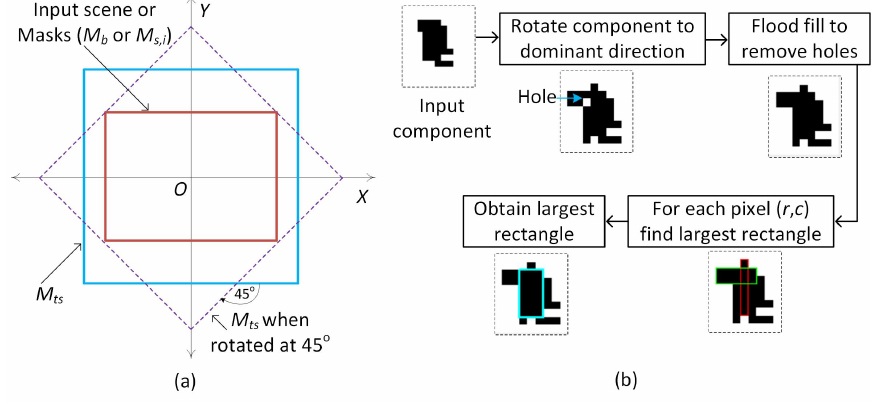
Figure 4. (a) Generation of the sub-mask – defining building mask M b , sub-mask M s,i and temporary sub-mask M ts . M b and M s,i have the same size as the input scene, (b) Steps to find the largest rectangle within a component. F y, 1 represents planes where the height remains constant along (h), where the height (ideally) remain constant in all directions. ϕ 1 but changes along φ 1 . Both of them also contain the flat sur- F x, 1 and F y, 1 are then converted back to the original orientation faces, as shown within pink coloured rectangles in Figure 3(g)- and size. In addition, occasional small holes, which may exist